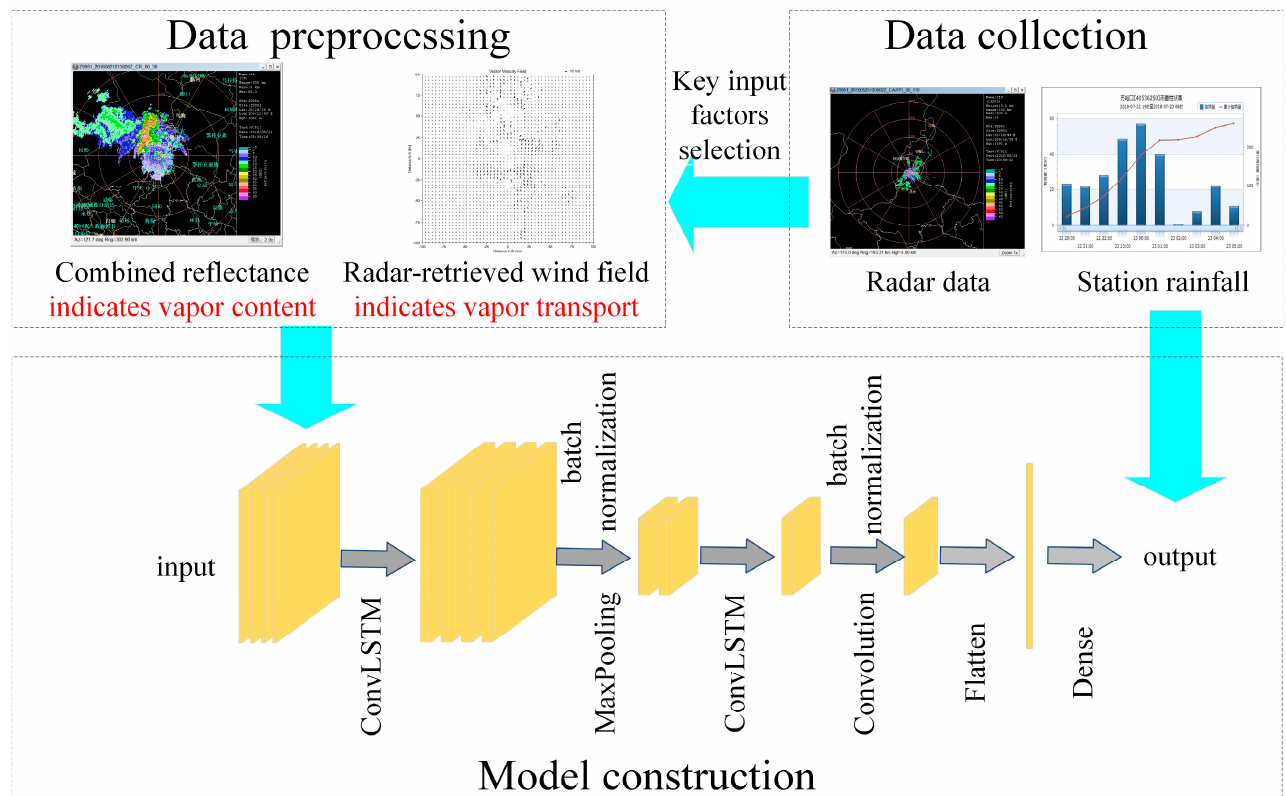
Figure 2. The main flow and a schematic illustration of the model